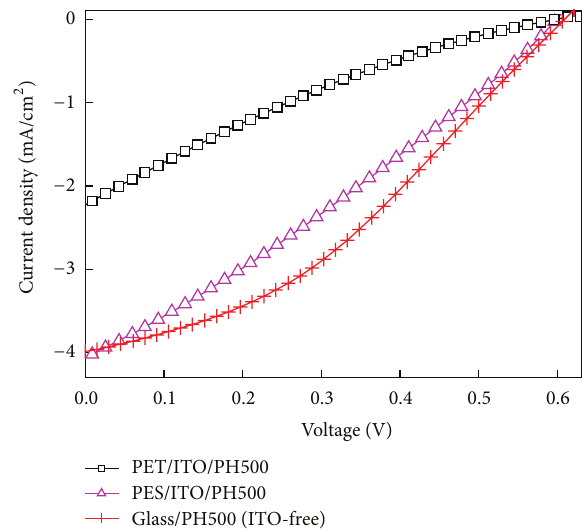
Figure 5: J-V characteristics of the ITO-free OPV device (glass/ PEDOT:PSS(PH500)/P3HT:PCBM/LiF/Al), the PET/ITO-based flexible plastic device (PET/ITO/PEDOT:PSS(PH500)/P3HT: PCBM/ LiF/Al), and the PES/ITO-based flexible plastic device